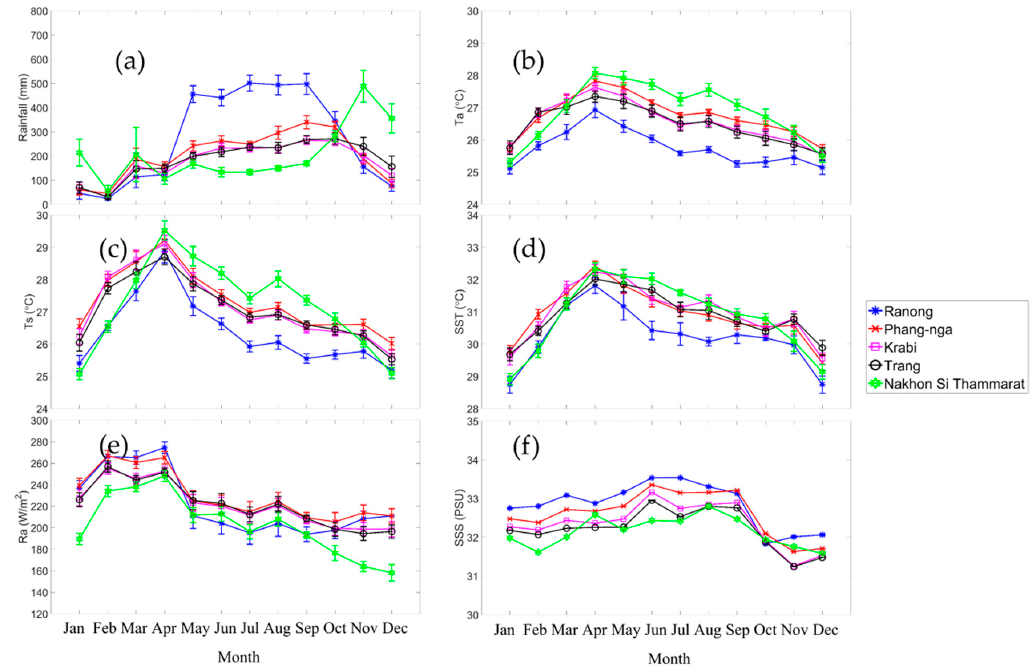
Figure 8. The seasonal pattern of six mangrove drivers with standard deviation (vertical bars) over 10 years: ( a ) rainfall, ( b ) Ta, ( c ) Ta, ( d ) SST, ( e ) Ra and ( f ) SSS. Remote Sens . 2018 , 10 , x FOR PEER REVIEW